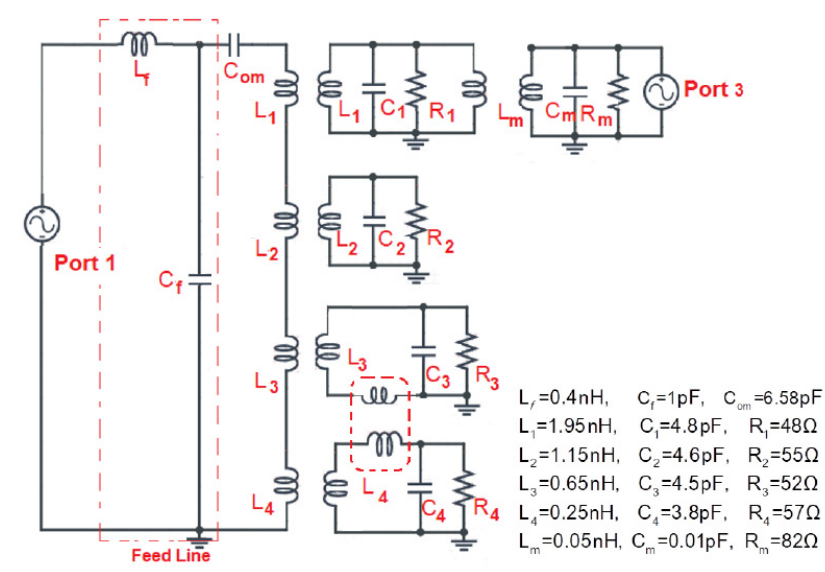
Figure 9. Equivalent circuit model of sub-6GHz and millimeter-wave radiator .